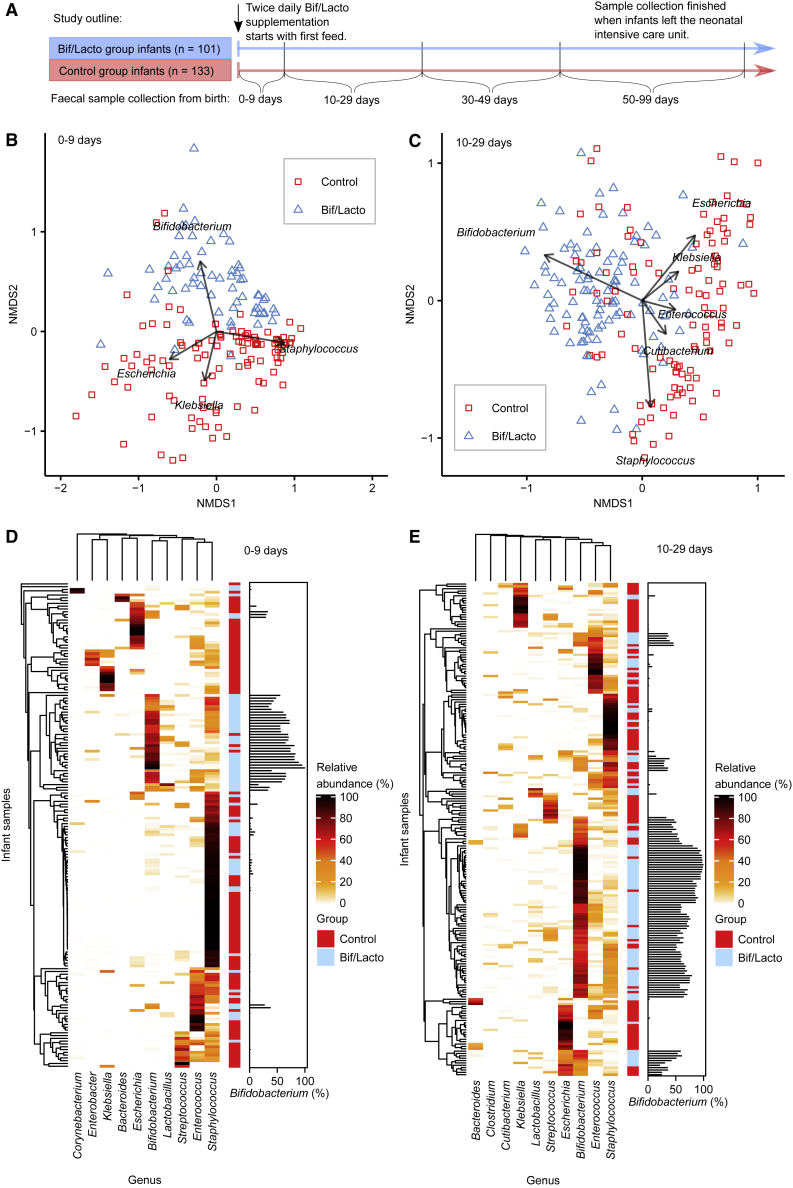
Premature Infant Gut Microbiota Clustering and Genus CompositionNMDS (non-metric multidimensional scaling) analysis clustered with a Bray-Curtis dissimilarity. Arrows and genus labels on the NMDS plots indicate bacterial genera driving the separation of points on the NMDS plots. Heatmaps showing the ten genera with highest proportional abundance. Heatmap rows were clustered by total microbiota similarity using Bray-Curtis dissimilarity and the columns clustered by genera that occur more often together. Side bar plots show the proportional abundance of Bifidobacterium in each sample.(A) Study outline and sample collections times. Infloran supplementation was given until 34 weeks old, except for very low-birth-weight infants (<1,500 g) who received it until discharge. The control group was not given supplementation.(B) NMDS plot of infant fecal microbiota at 0–9 days (control: n = 110, Bif/Lacto: n = 64).(C) NMDS plot of infant fecal microbiota at 10–29 days (control: n = 109, Bif/Lacto: n = 100).(D) Heatmap showing infant fecal microbiota at 0–9 days (control: n = 110, Bif/Lacto: n = 64).(E) Heatmap showing infant fecal microbiota at 10–29 days (control: n = 109, Bif/Lacto: n = 100).See also Figure S1, Data S1–S3, and Tables S1 and S3.